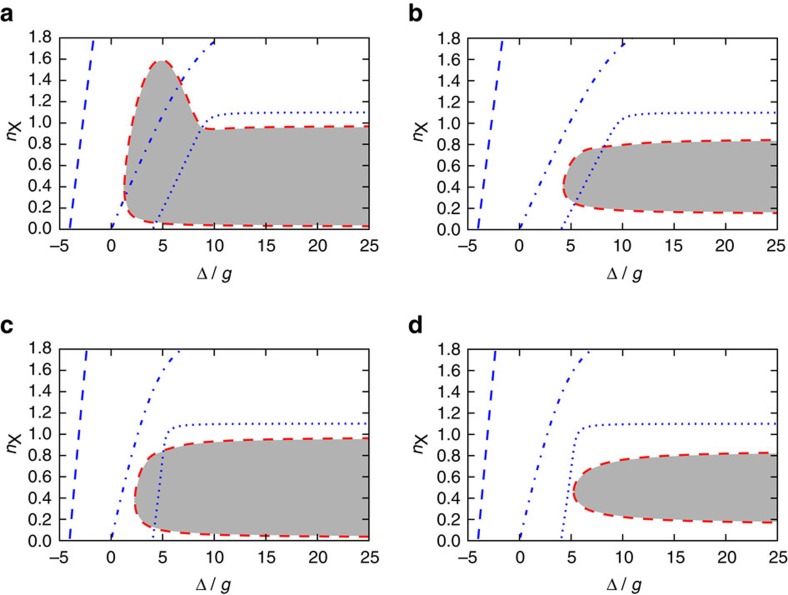
Phase diagram of a graphene integer QHPF.White (grey-shaded) regions represent the values of the detuning Δ—in units of g—and density nX of total excitations at which the homogeneous phase described by equations (17, 18, 19) is stable (unstable). (a) κr=5 and M=1; (b) κr=5 and M=2; (c) κr=15 and M=1; and (d) κr=15 and M=2. In each panel, blue lines denote the location of points in the plane (Δ/g,nX), where the ratio between the number of excitons and the number of photons is constant: nex/nph=1/10 (dashed line), nex/nph=1 (dash-dotted line) and nex/nph=10 (dotted line). These curves have been calculated with reference to the homogenous phase.